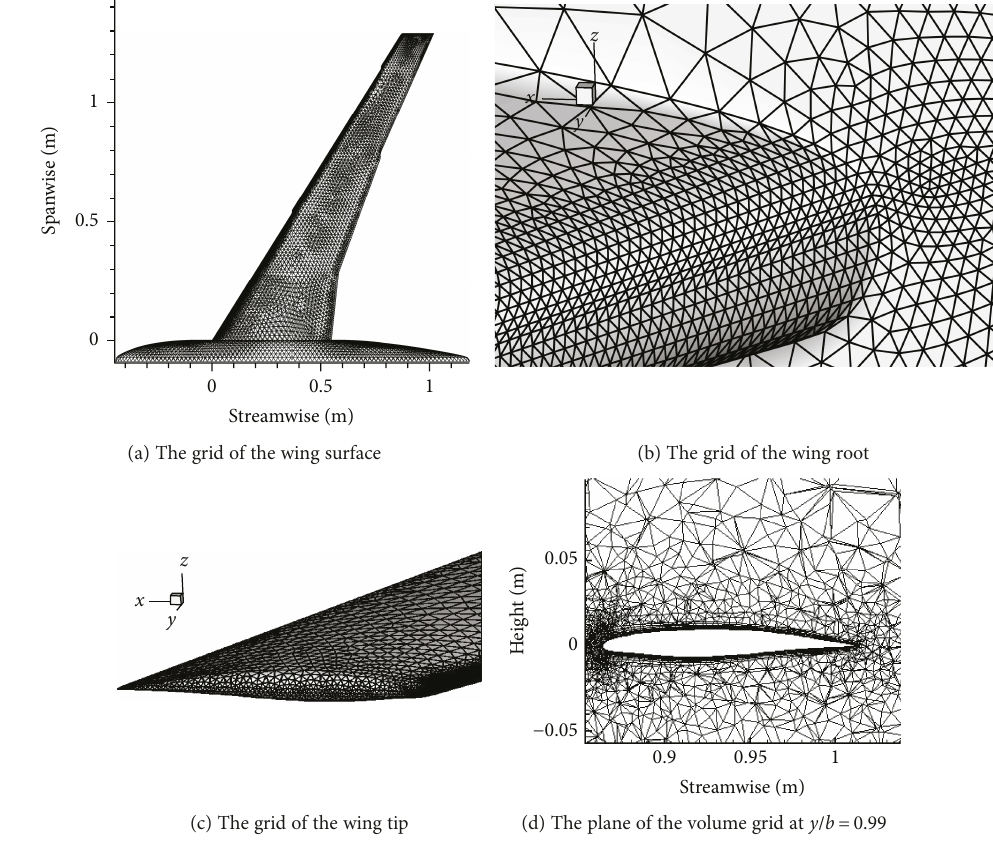
Figure 5: The details of the grid ( x : streamwise, y : spanwise, z : height). Table 5: The sampling data of Mach number and angle of